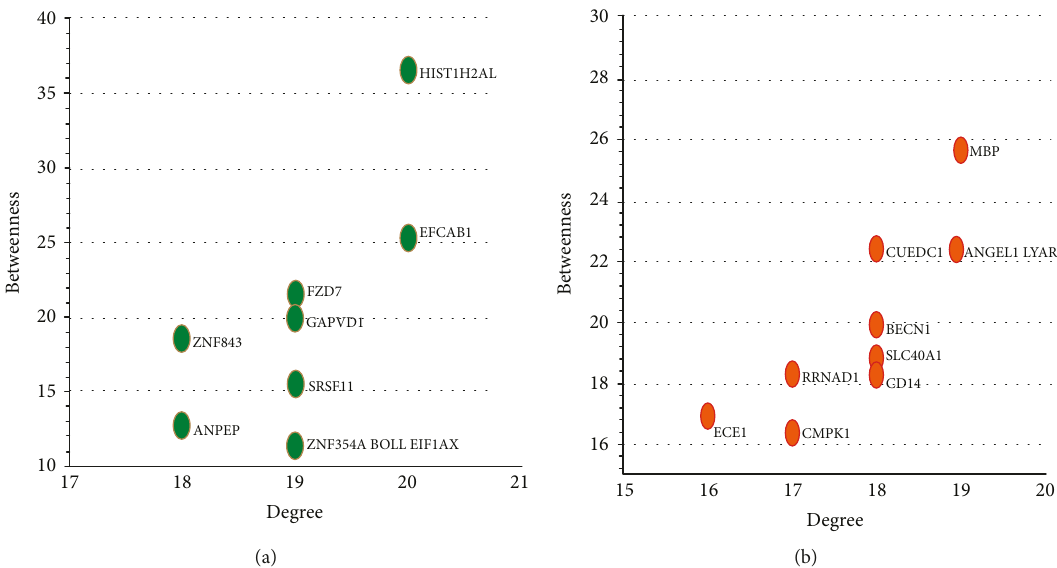
Figure 3: (a) Top 10 LMGs with the highest degree and betweenness. (b) Top 10 HMGs with the highest degree and